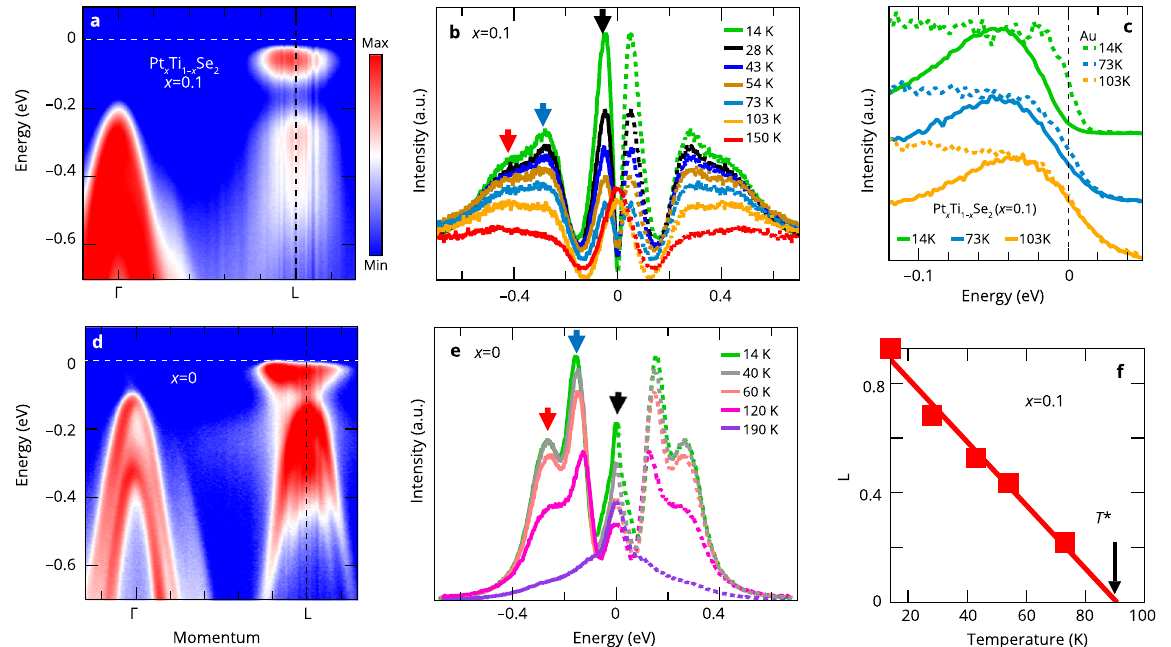
Fig. 3 Pseudogap-like suppression in ARPES spectra. a ARPES energy-momentum intensity map (EMIM) for the x = 0.1 sample at T ~ 14 K along Γ L direction. b Symmetrized EDCs as a function of temperature at the L point marked by the black dashed lines in a and d . The positive- energy parts of the spectra are shown by dotted lines. c Comparison of the zoomed-in views close to μ of the leading edges of the EDCs from the x = 0.1 sample and a polycrystalline gold sample at 14, 73, and 103 K. The leading edges of the EDCs of the Pt-doped sample are shifted toward negative energy with respect to that of gold at 14 and 73 K. This shift, and hence the energy gap, is absent at 103 K. d , e are respectively the same as a and b but for x = 0. f Temperature evolution of the fi lling up parameter L ð T Þ (cid:3) 1 (cid:4) I ð T ; 0 Þ The black arrow points to the anticipated value of T *, obtained from the extrapolation of L to zero. The red and blue arrows in b and e correspond to the CDW replica bands due to zone folding. Black arrows correspond to the spectral features associated with the conduction bands at the L